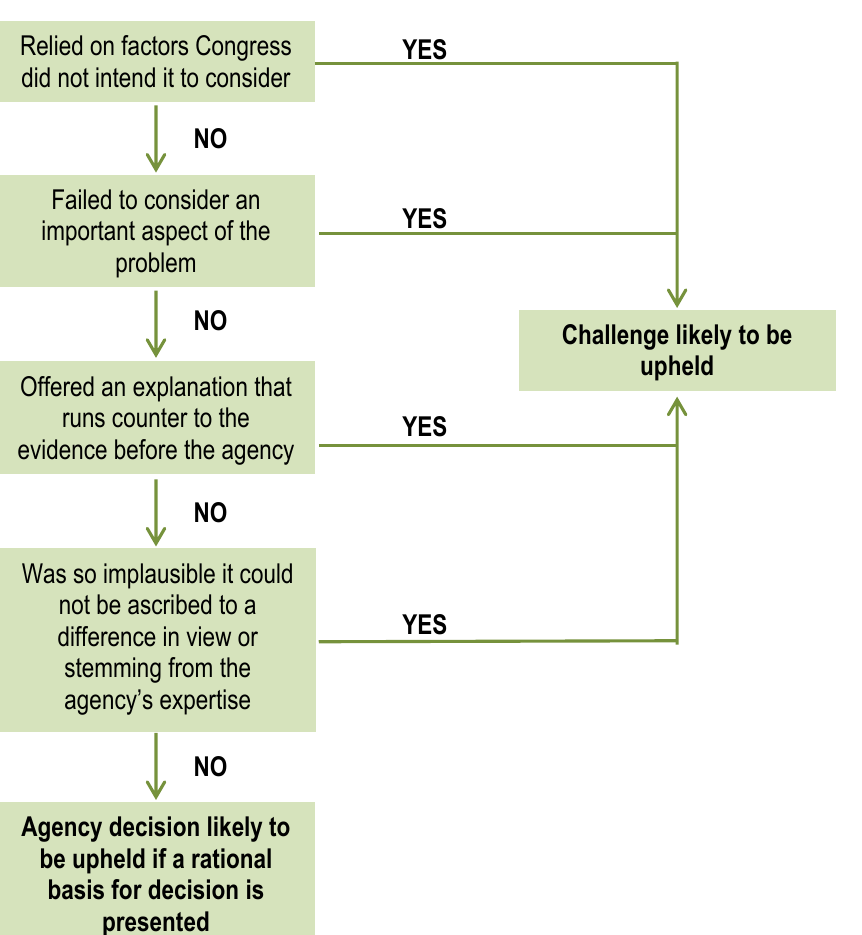
Figure 2. Under the APA, the court will conduct a “searching and careful” review and ask whether the agency made a decision that was not “arbitrary and capricious”. (Note that the steps are not necessarily